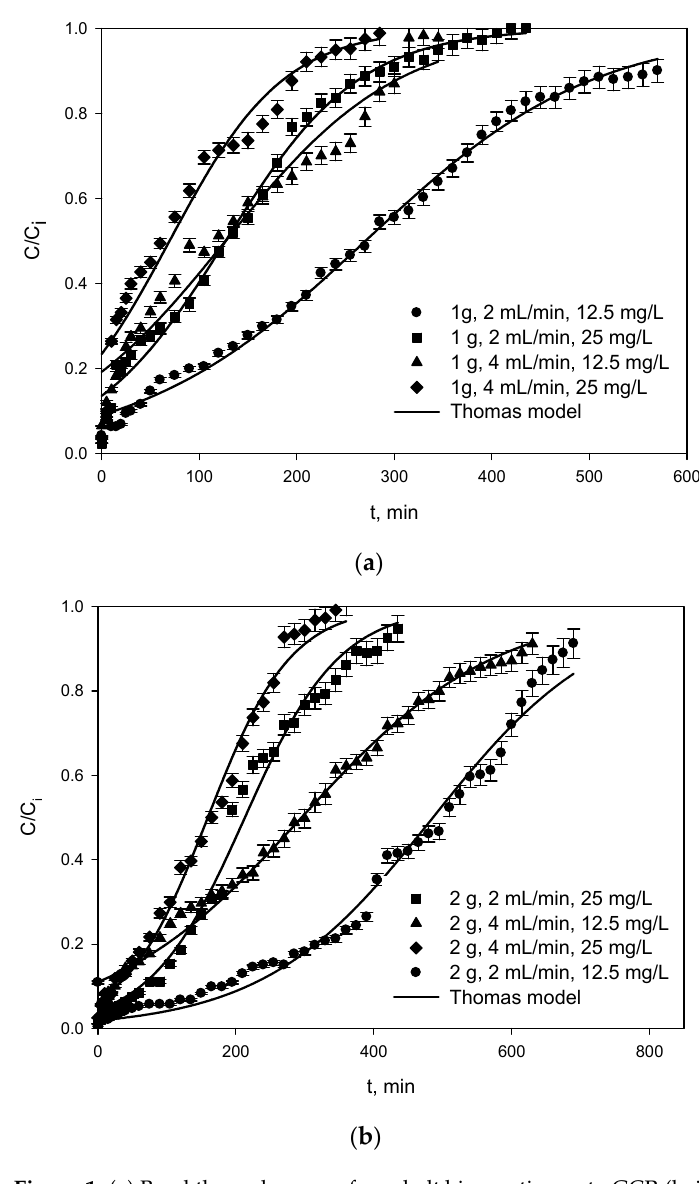
Figure 1. ( a ) Breakthrough curves for cobalt biosorption onto GCR (height of 5 cm). ( b ) Breakthrough curves for cobalt biosorption onto GCR (height of 11.5 cm). Table 2. Main parameters of the breakthrough curves for the different operating conditions.